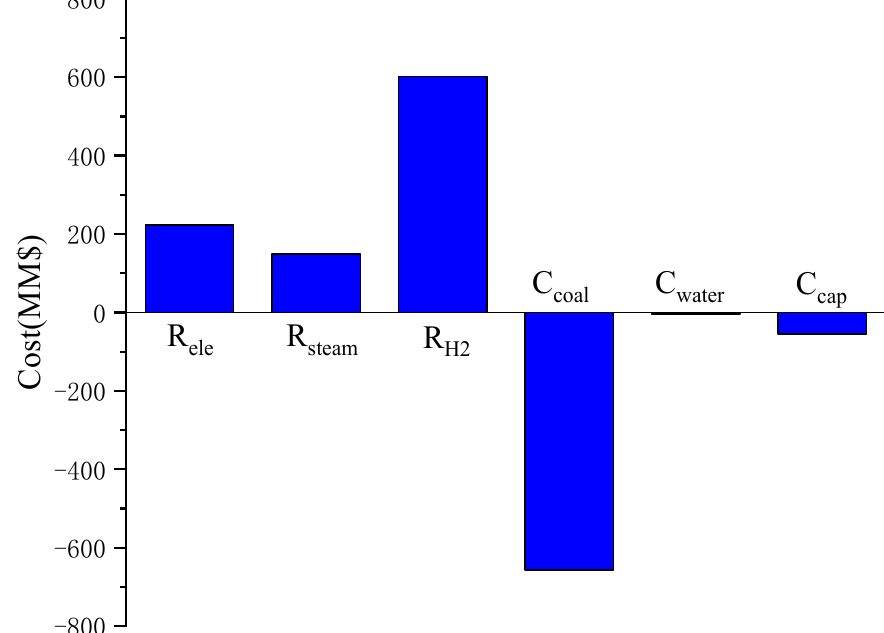
Figure 2. Breakdown of the costs of the integrated system.